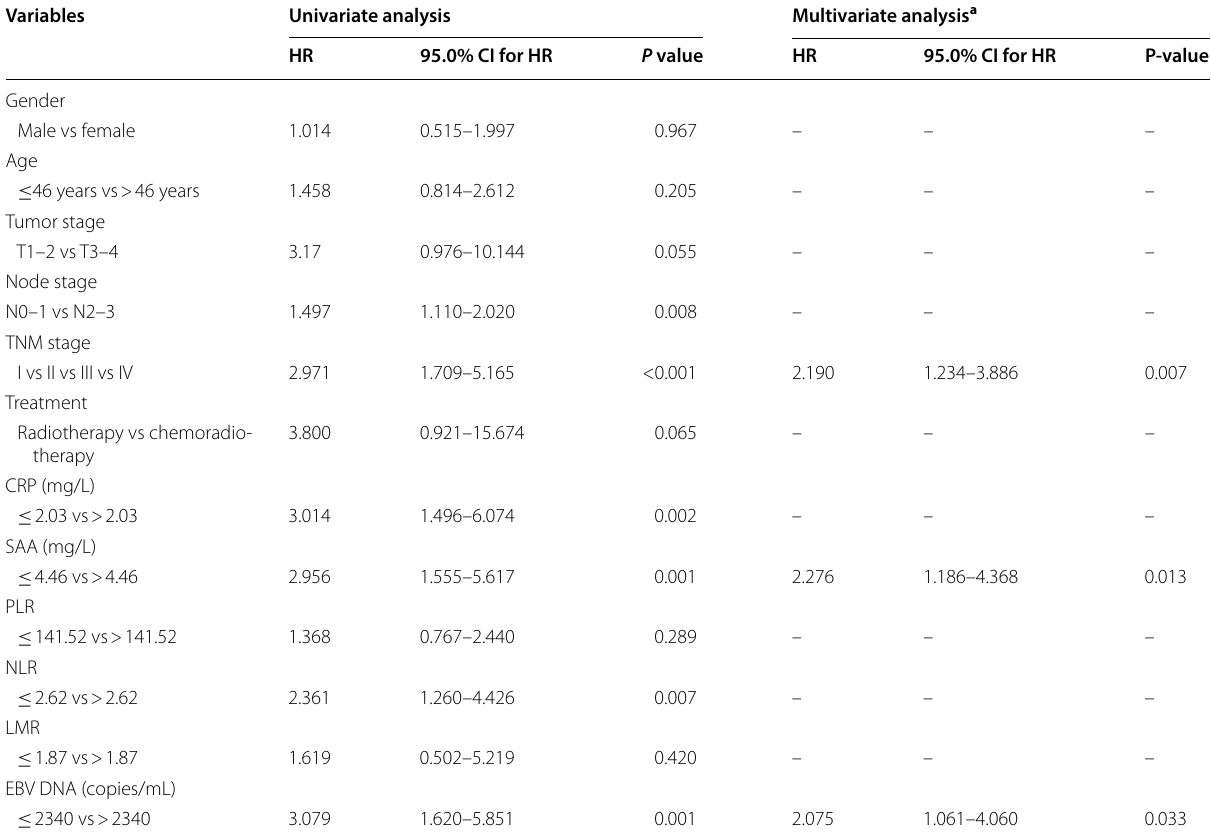
Table 2 Univariate and multivariate analysis for overall survival (OS) for the 304 patients with NPC